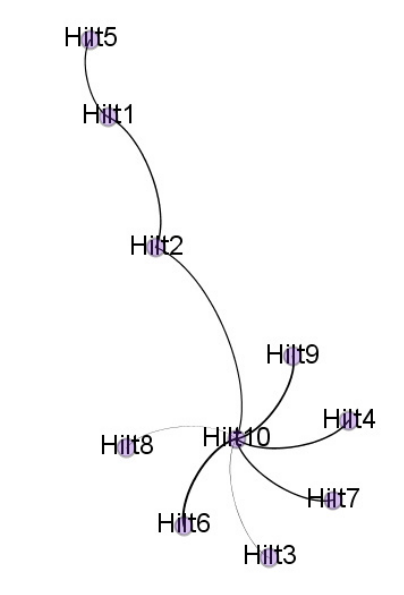
Figure 7. Network graph using the MST of hilt clusters using the Force Atlas